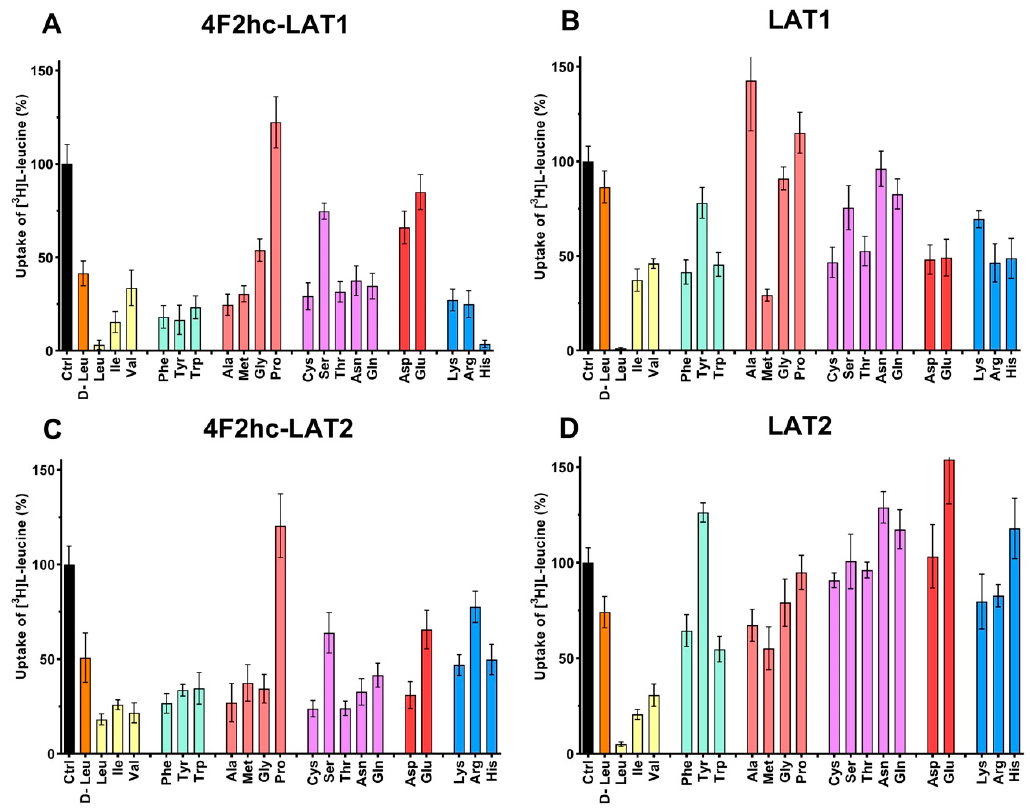
Figure 3. Determination of the substrate specificity of 4F2hc-LAT1 ( A ), LAT1 ( B ), 4F2hc-LAT2 ( C ), and LAT2 ( D ) by 100 nM [ 3 H]L-leucine uptake competition assay. With the exception of D-leucine, proteogenic L-amino acids were used as competitors. Competitor concentrations of 250 µ M (( A ); 4F2hc-LAT1), 100 µ M (( B ); LAT1), 2500 µ M (( C ); 4F2hc-LAT2), and 500 µ M (( D ); LAT2) were used. These concentrations correspond to about ten times the determined L-leucine K m values of the corresponding transporters (Figure 2). Residual uptake in the presence of competitor was normalized with respect to control samples without competitor (Ctrl). The amino acids are abbreviated using their three-letter-code. Means with SD from normalized data of three independent experiments, each at least in triplicate are shown. If not visible, error bars are smaller than symbols.